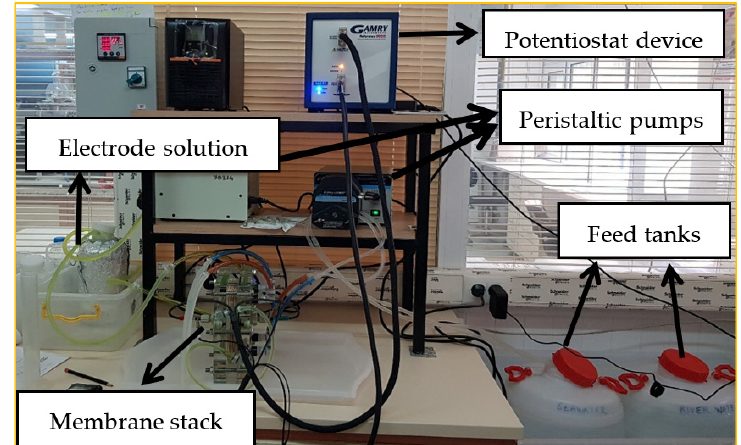
Figure 4. RED system components. Table 2. Technical information of RED stack.